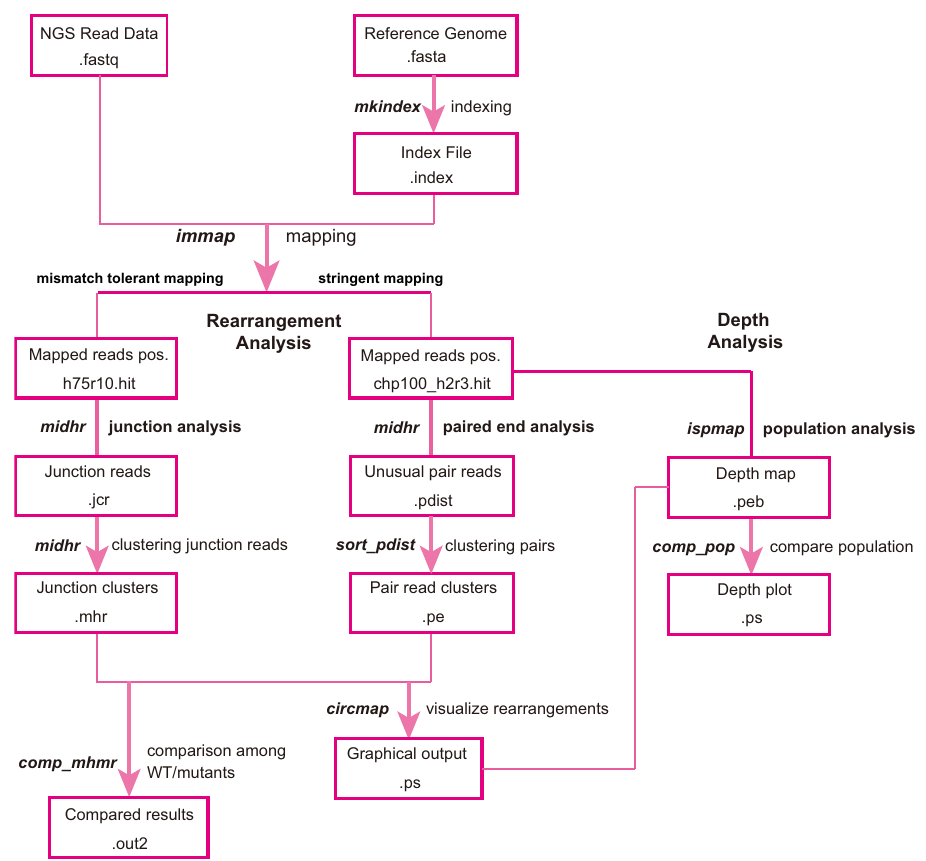
Fig. 4 Flow chart of the computational analysis. Reads are mapped to the reference genomes by immap in two ways. For the analysis of rearrangements using paired-end reads, truncated (100 bp) reads mapped under stringent conditions are analyzed by midhr to identify rearrangements with unusual positions. Identi fi ed unusual pairs are subsequently clustered by sort_pdist and visualized by circmap. For the analysis of rearrangements using junction reads, reads (150 bp) mapped under mismatch-tolerant conditions are analyzed by midhr to identify and create junction clusters, and the clustered junction reads are visualized by circmap. The results of paired-end reads and junction reads are compared between strains by